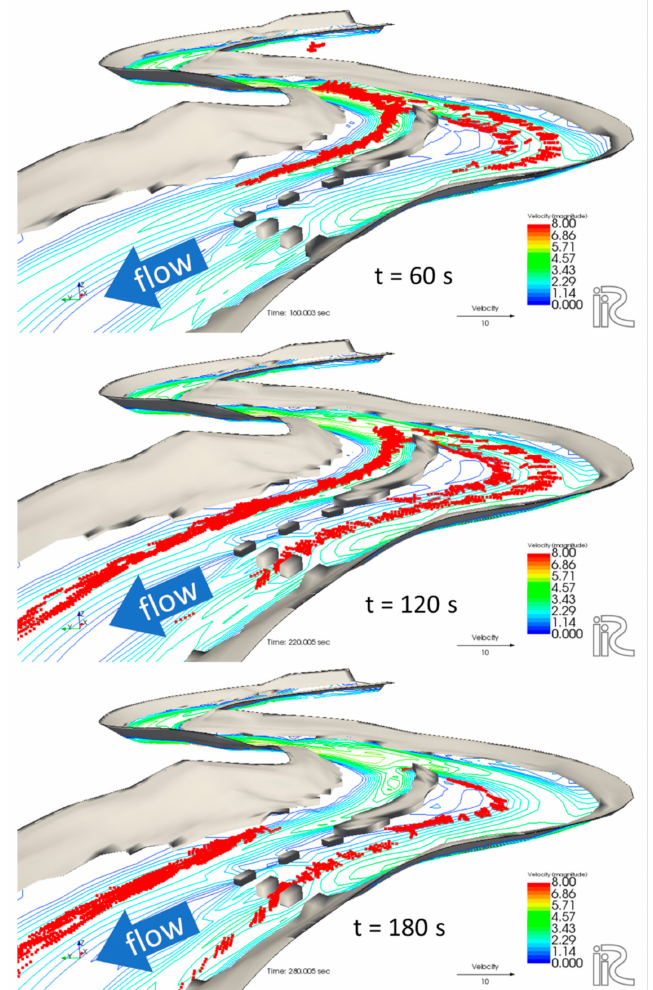
Figure 14. Simulated driftwood behavior together with streamlines in the vicinity of the riverbed (Run 1, bird-eye view, red bars: driftwood pieces, vertical grid division: 10 layers, t: elapsed time after driftwood